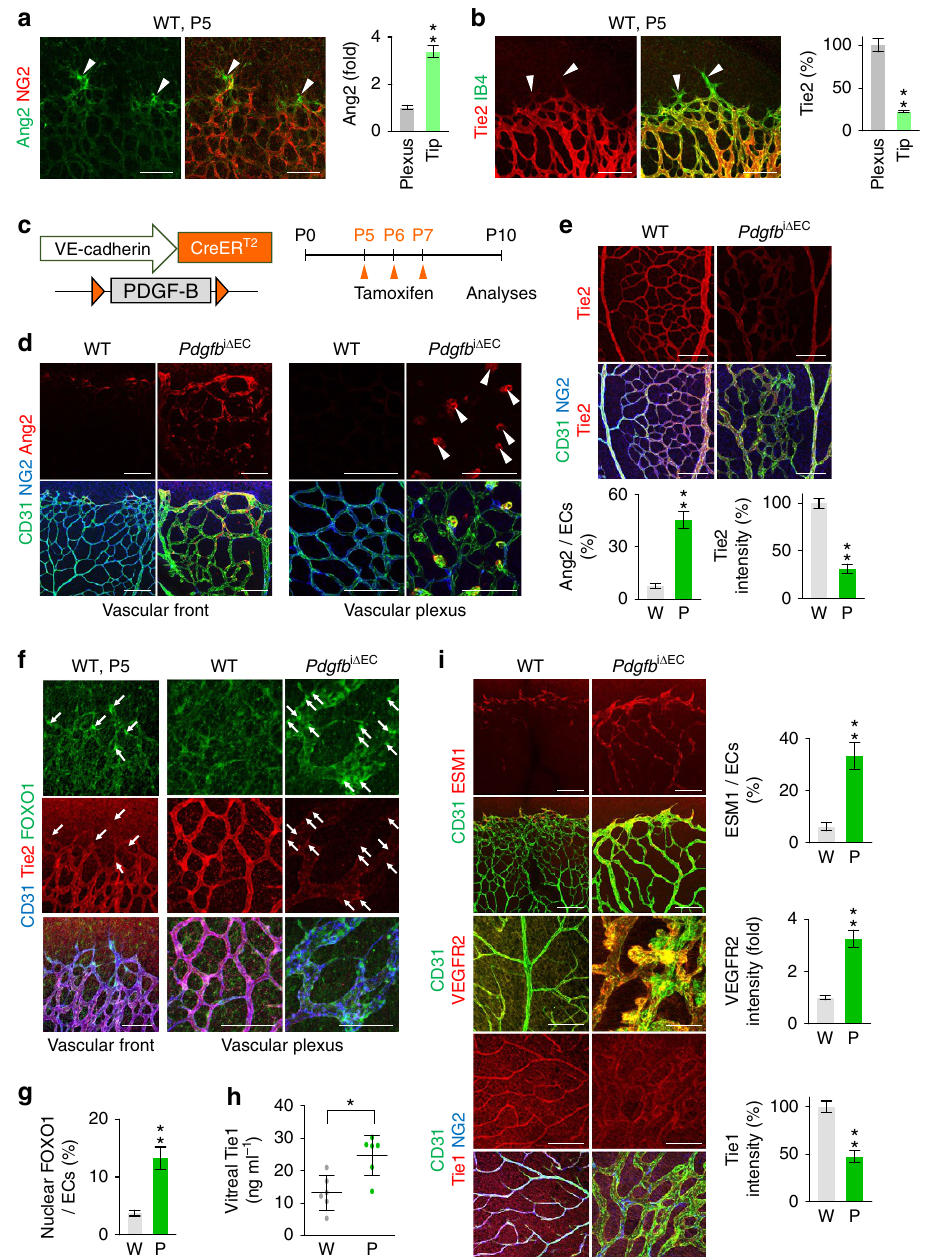
Figure 3 | Inadequate pericyte coverage activates FOXO1-Ang2 axis in ECs. ( a , b ) Images and comparisons of Ang2 and Tie2 expressions in vascular front of retinas of WT mice at P5. Tip ECs that are not covered with NG2 þ pericytes (arrowheads) express high Ang2 and low Tie2. Analyses were performed in 6 representative areas per retina in WT mice ( n ¼ 6). ( c ) Diagram depicting the experiment schedule for EC-specific deletion of PDGF-B in retinal vessels from P5 and their analysis at P10 in Pdgfb i D EC mice. ( d , e ) Images and comparisons of Ang2 and Tie2 expressions in CD31 þ vessels. Increased expression of Ang2 are observed in vascular front and microaneurysm, while Tie2 expression is decreased in retinal vessels of Pdgfb i D EC mice (P; n ¼ 6) compared with WT mice (W; n ¼ 6). ( f ) Expressions and localizations of FOXO1 and Tie2 in vascular front of WT mice at P5 and in vascular plexus at P10 in WT mice and Pdgfb i D EC mice. Note that nuclear localization of FOXO1 (arrows) is evident in Tie2-low tip ECs of WT mice and pericyte- detached ECs in Pdgfb i D EC mice. ( g ) Quantification of the nuclear FOXO1 in the CD31 þ vessels in WT (W; n ¼ 6) and Pdgfb i D EC (P; n ¼ 6) mice. ( h ) Comparison of soluble Tie1 in vitreous fluid of eyes of WT (W; n ¼ 6) and Pdgfb i D EC (P; n ¼ 6). ( i ) Expressions, localizations, and comparisons of ESM1, VEGFR2 and Tie1 in CD31 þ retinal vessels of WT (W; n ¼ 6) and Pdgfb i D EC (P; n ¼ 6). Error bars represent mean ± s.d. * P o 0.05, ** P o 0.01 versus WT by Mann–Whitney U test. All scale bars, 100 m m.